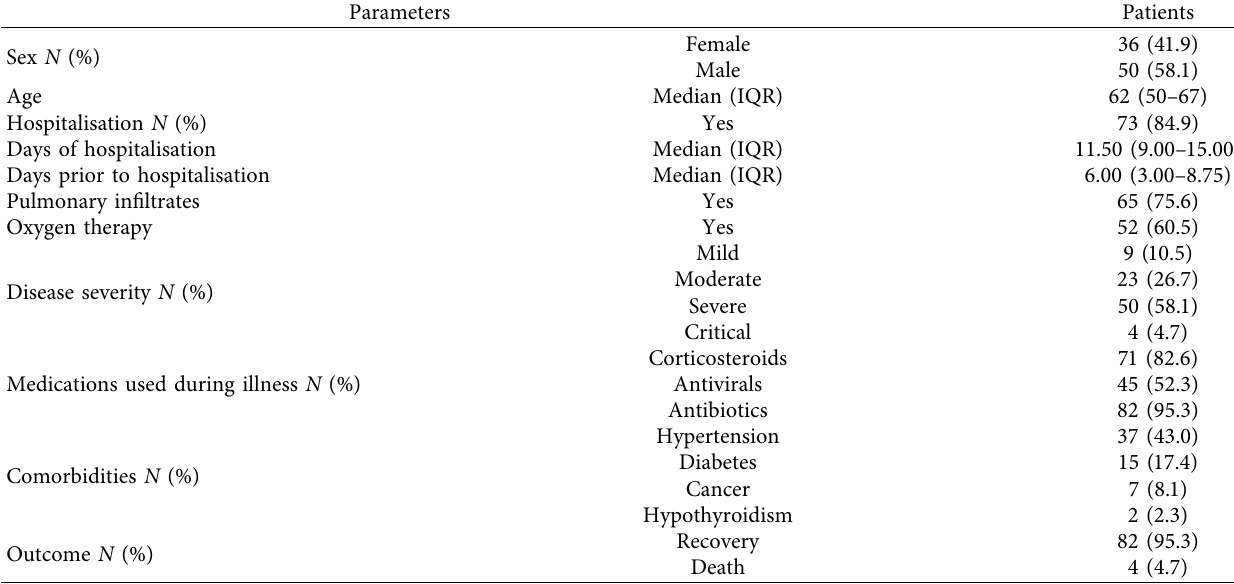
Table 1: Demographic and clinical parameters of COVID-19 patients.